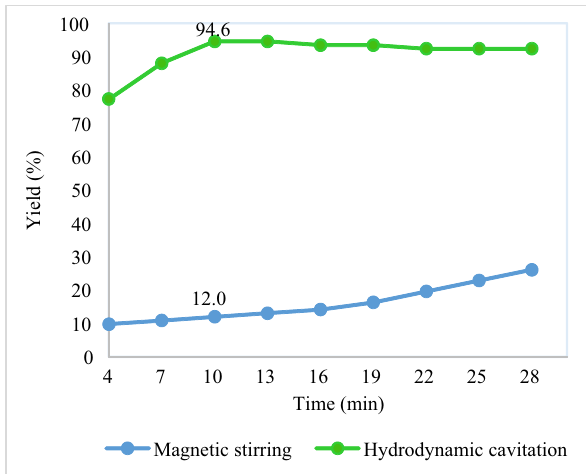
Figure 9: Comparison of the performance of the hydrodynamic cavitation device and the magnetic